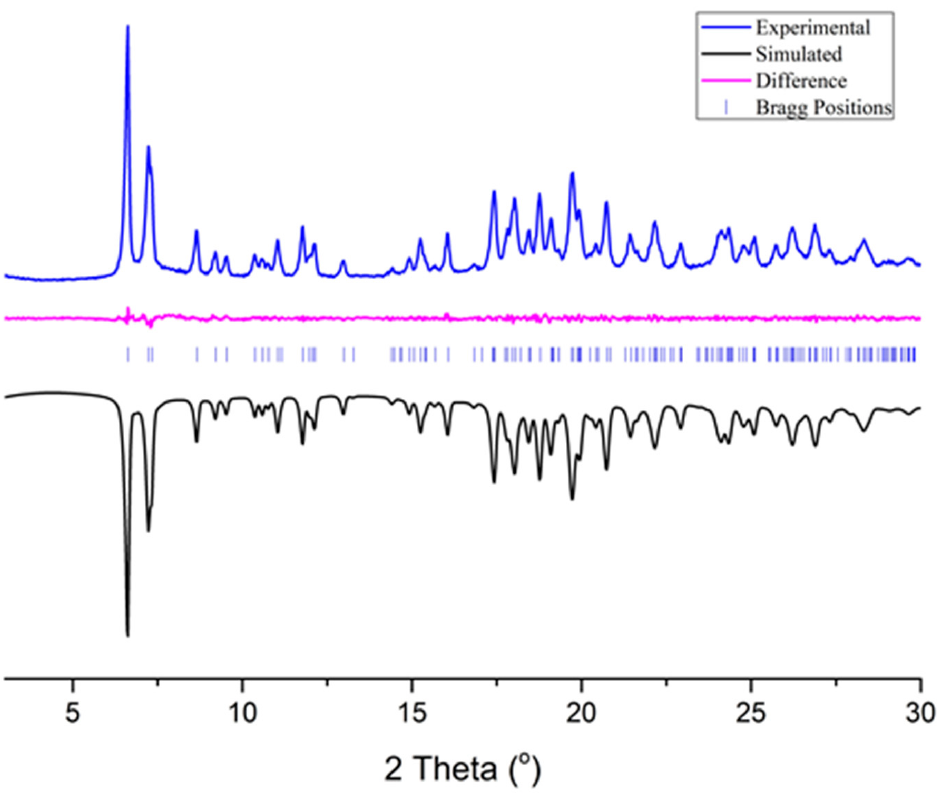
Figure 1. The final plot of the Rietveld refinement, showing the experimental, simulated (reverted) and difference powder diffraction patterns of [Fe 3 O(PhCO 2 ) 6 (H 2 O) 3 ] · PhCO 2 . Vertical markers refer to the calculated positions of the Bragg reflections (Table S4).